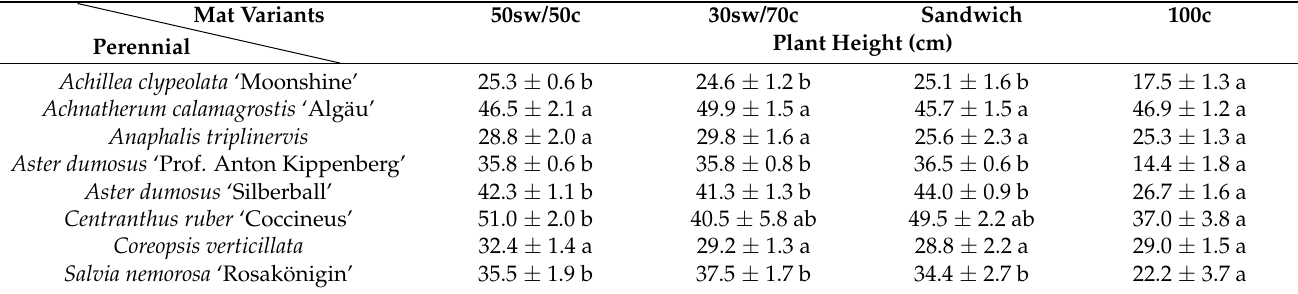
Table 6. Average plant height ( ± SE) of all perennials on different mat variants at the 7th